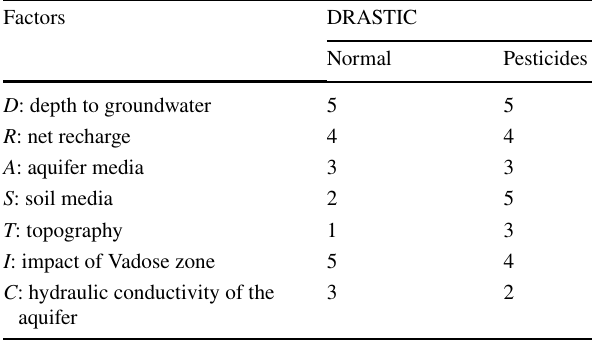
Table 1 Weights of the factors in the DRASTIC (Normal and Pesti- cides) scenarios. (Reproduced with the permission from Aller et al.